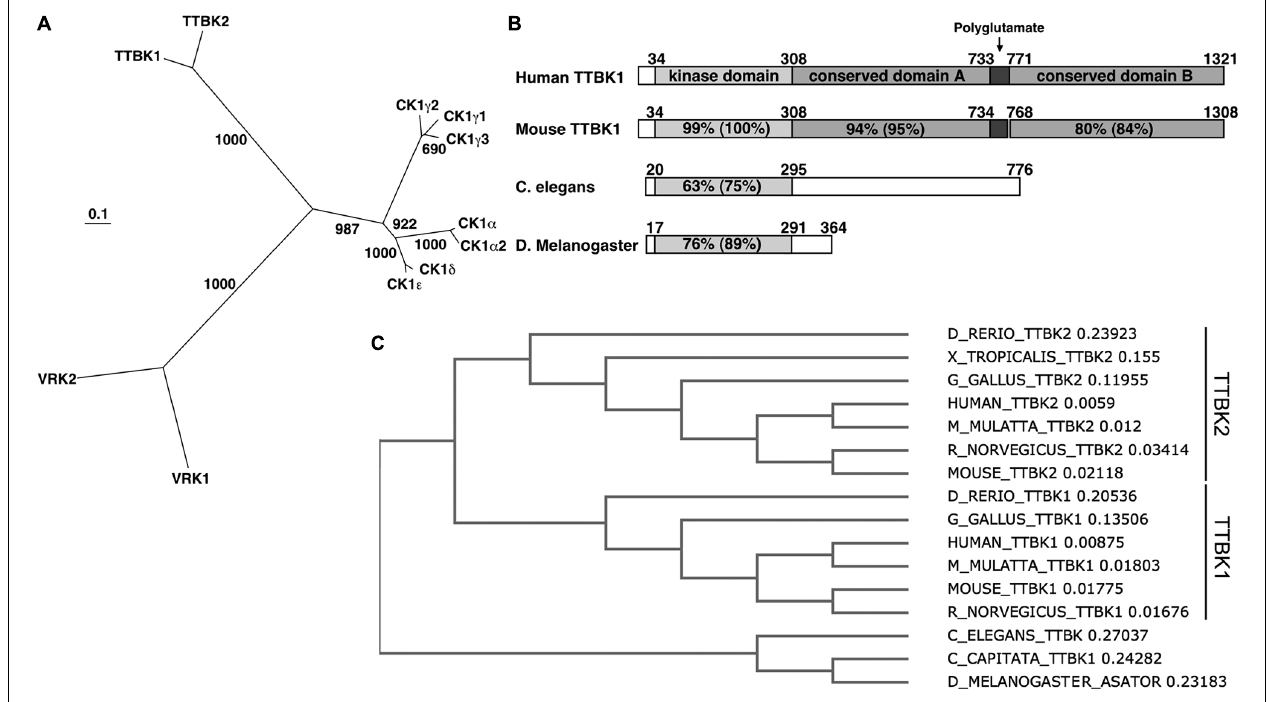
FIGURE 1 | Dendrogram of CK1 group and sequence conservation of TTBK1. (A) Phylogenetic tree of human casein kinase family. The scale bar represents 0.1 amino acid substitution per site. Bootstrap values (1,000 bootstrap iterations) are indicated. VRK3 was removed due to low homology to other kinases in CK1 family. (B) Alignment of human and mouse TTBK1, and C. elegans and D. melanogaster TTBK amino acid sequences. TTBK1 34–308, dual-kinase domain; 309–732,